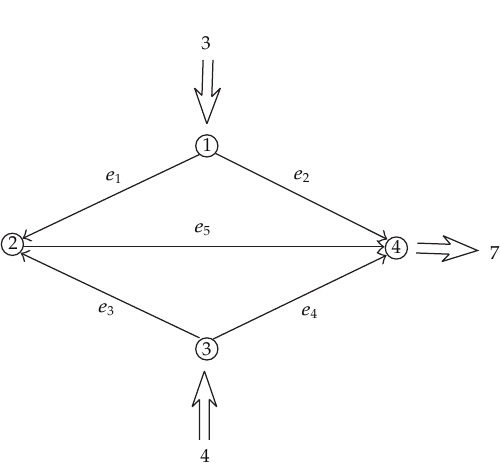
Figure 1: Network topology for an